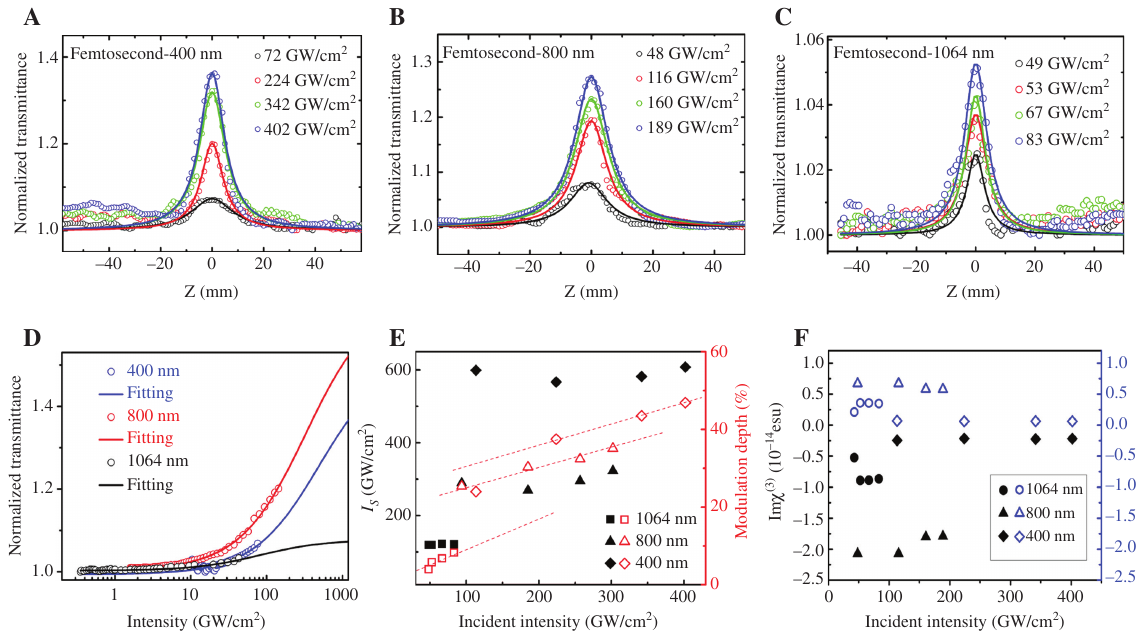
Figure 2: Wavelength dependent nonlinear optical absorption of GeSe NPs. (A), (B) and (C) Open aperture Z-scan measurements of GeSe NPs dispersions under different intensities at 400, 800, and 1064 nm, respectively; (D) relations of normalized transmittance and input intensity of GeSe NP dispersions at 400, 800, and 1064 nm, respectively; (E) the NLO parameters about GeSe dispersions’ saturated intensity I and MD; (F) the imaginary part of the third-order susceptibility Im χ (3) s and the figure of merit (FOM) for the third-order optical nonlinearity of GeSe NPs.